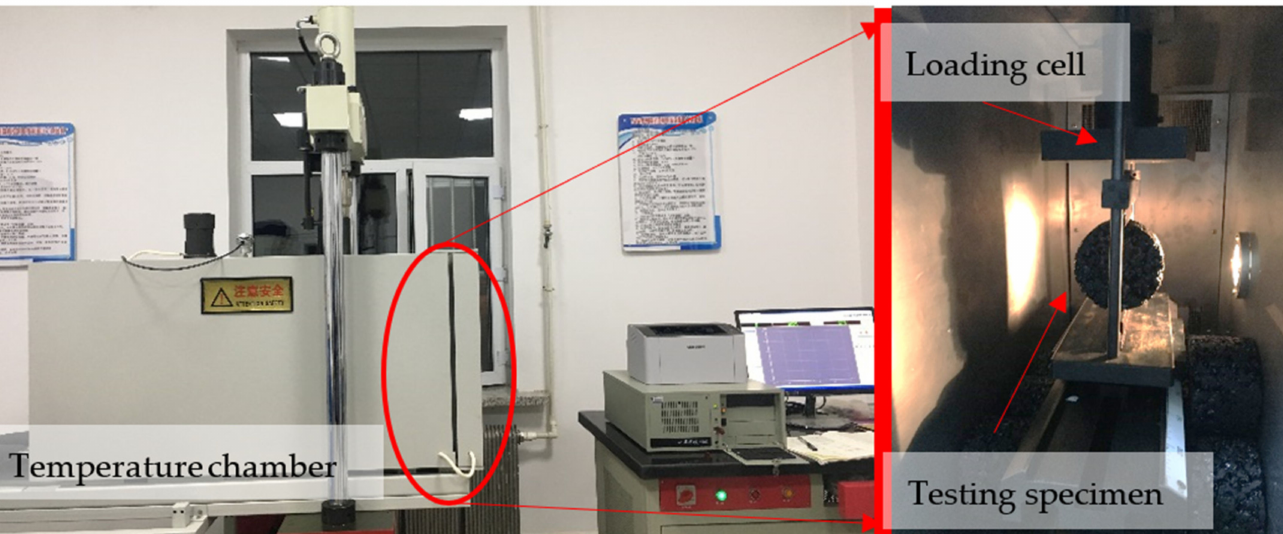
Figure 2. Universal testing machine. During the IDT process, asphalt concrete released energy from a local source and generated transient elastic waves, which is detected by the AE sensor and then amplified, processed, and recorded. By analyzing the recorded AE parameters, the damage mechanism of asphalt concrete could be characterized. The SAEU2S data acquisition system with six channels developed by Soundwel Technology Co. Ltd. (Beijing, China) was employed to conduct the test. The sampling accuracy of the acquisition card was ± 1 dB, and the A/D conversion type was 16 bit, 10 MS/s. In order to filter out ambient noise during the acquisition process, the threshold value was set to 40